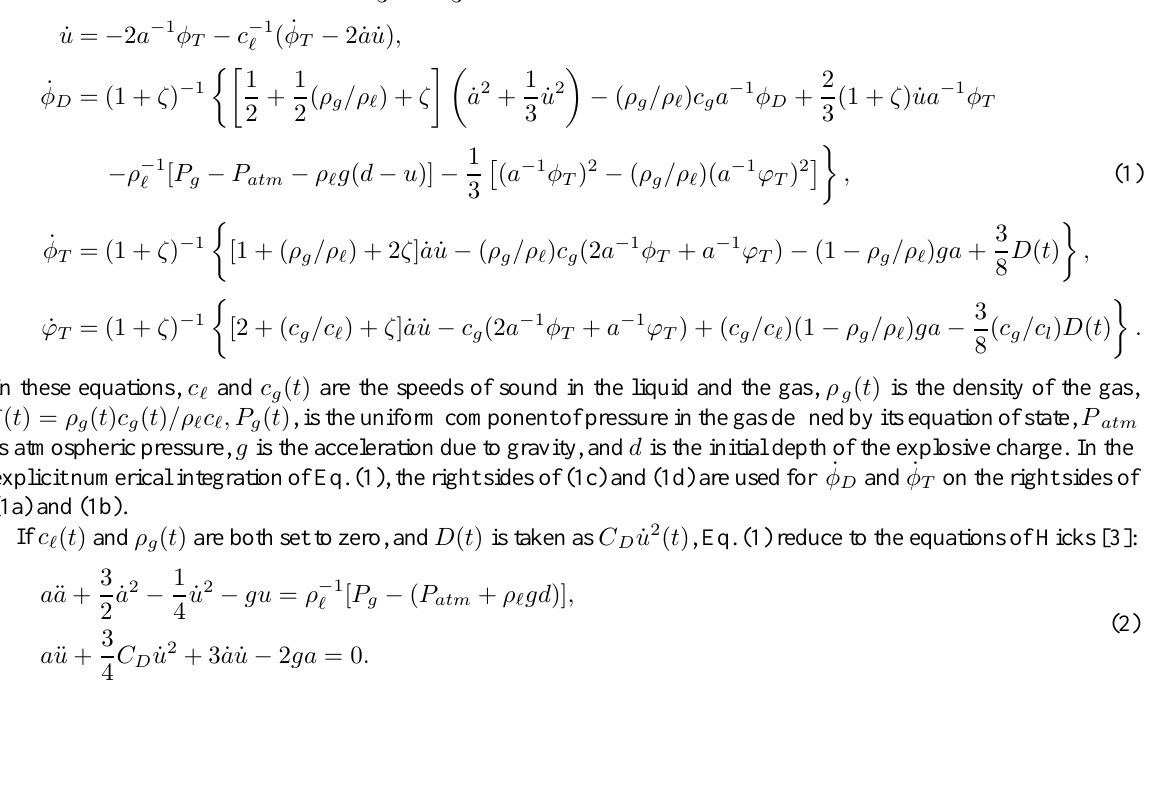
Fig. 1. Dilation and translation histories for a 1000-lb charge of TNT detonated at a depth of 250 ft, calculated with two different hydrodynamic drag coefficients. C D = 0.0 (dashed), C D = 2.25 (solid). 1 2 ˙ u 2 − ˙ ua − 1 φ ˙ a = a − 1 φ − c − 1 ( ˙ φ − ˙ a 2 − ) D D T 3 3 (cid:1)